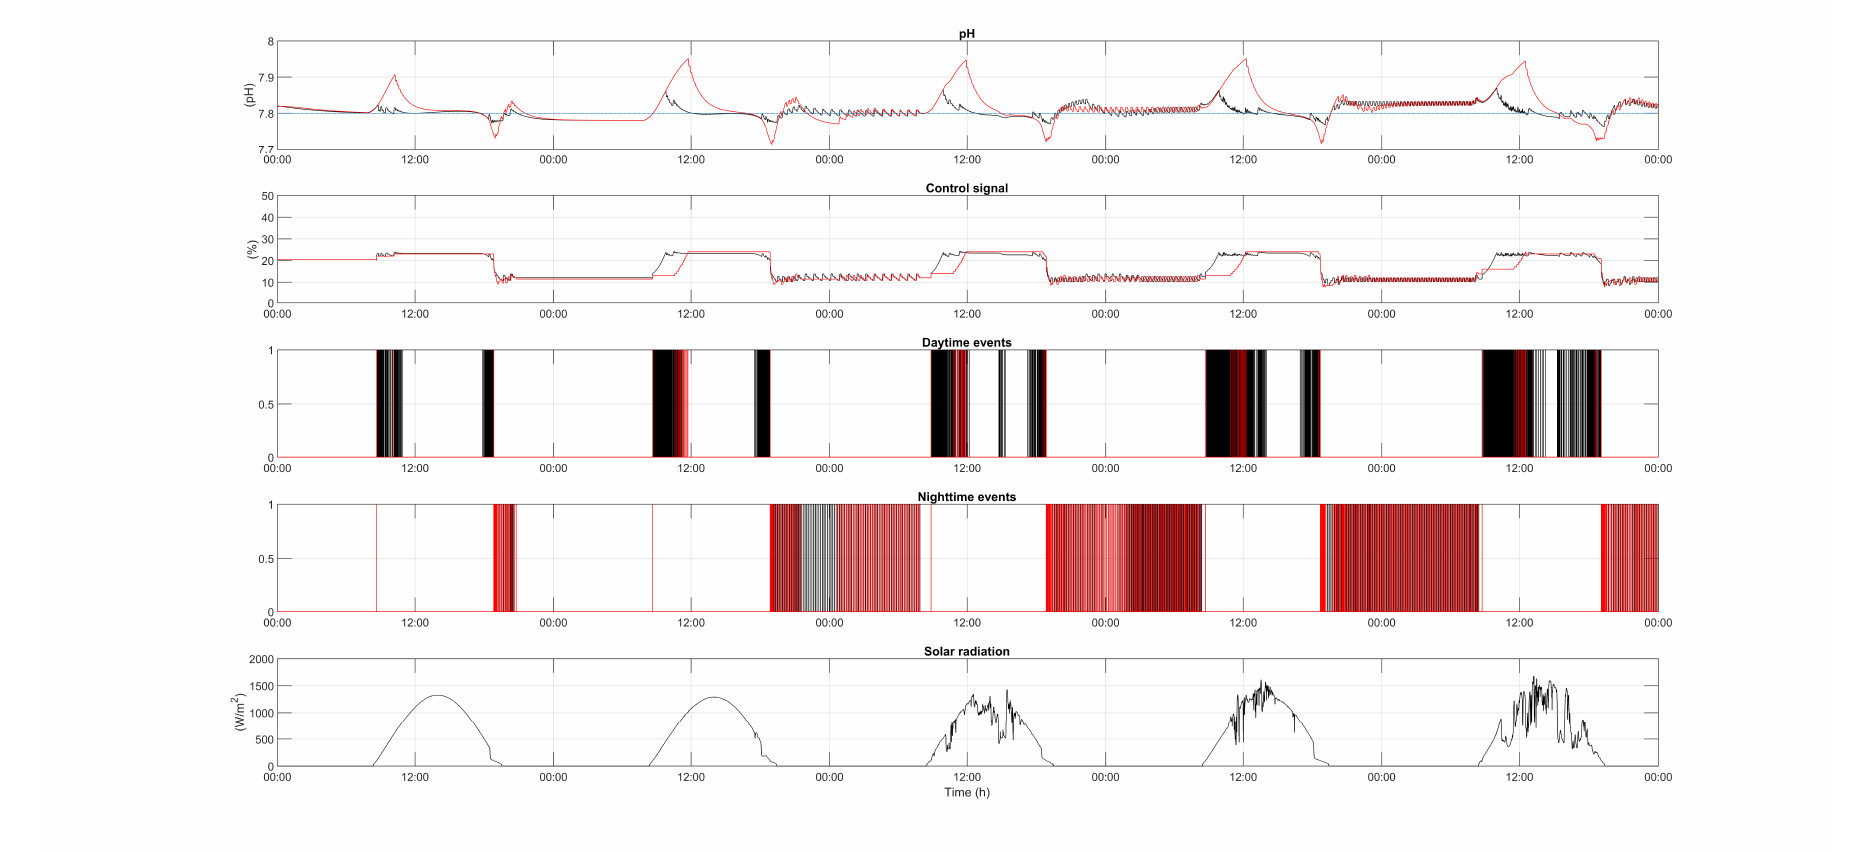
Figure 7. Results with the PI-SSOD controller. ∆ = 0.001 (black) and ∆ = 0.01 (red). First plot: pH output. Second plot: control signal. Third plot: diurnal events. Fourth plot: nocturnal events. Fifth plot: solar